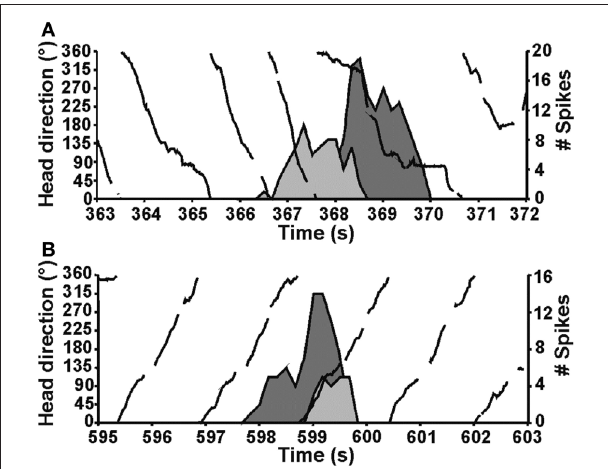
FIGURE 6 | The direction of the animal’s movement strongly predicted the order of cell firing when pairs of HD or bursty cells were recorded simultaneously (HD, solid black line). Two different episodes are shown for the same pair of cells. During an episode when the animal made CCW turns (top), cell 1 (dark gray fill) fired a burst before cell 2 (light gray fill). In contrast, during an episode with CW head turns (bottom), cell 1 fired after cell 2. Plots in (A,B) are from Muir et al., 2009.